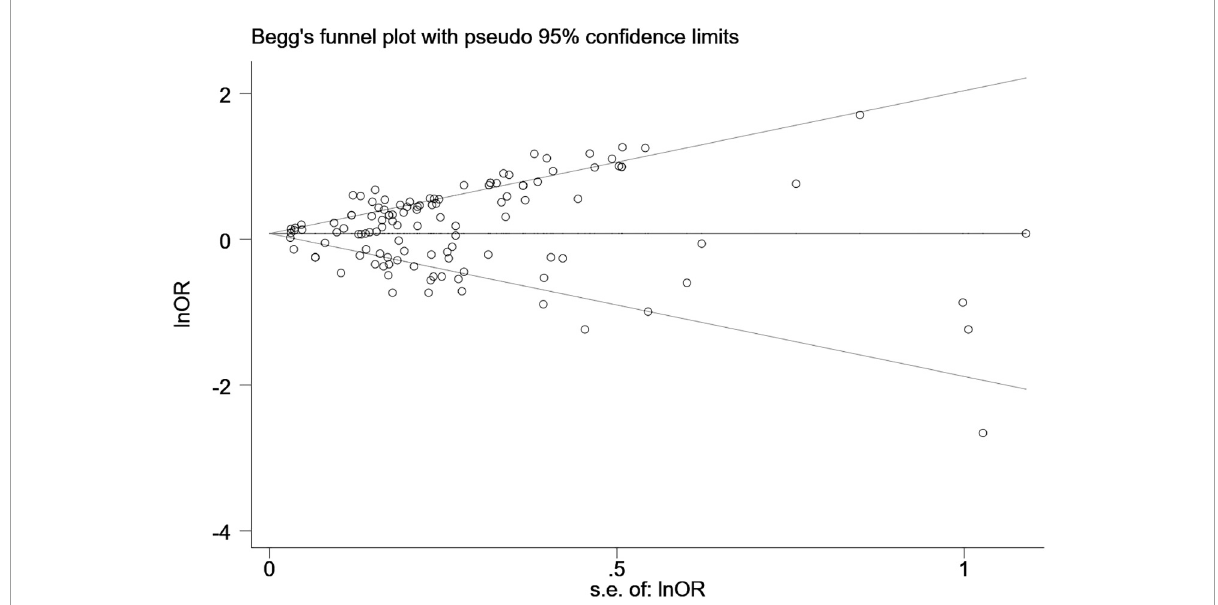
FIGURE2 Begg’s funnel plot of the association between pet ownership and childhood